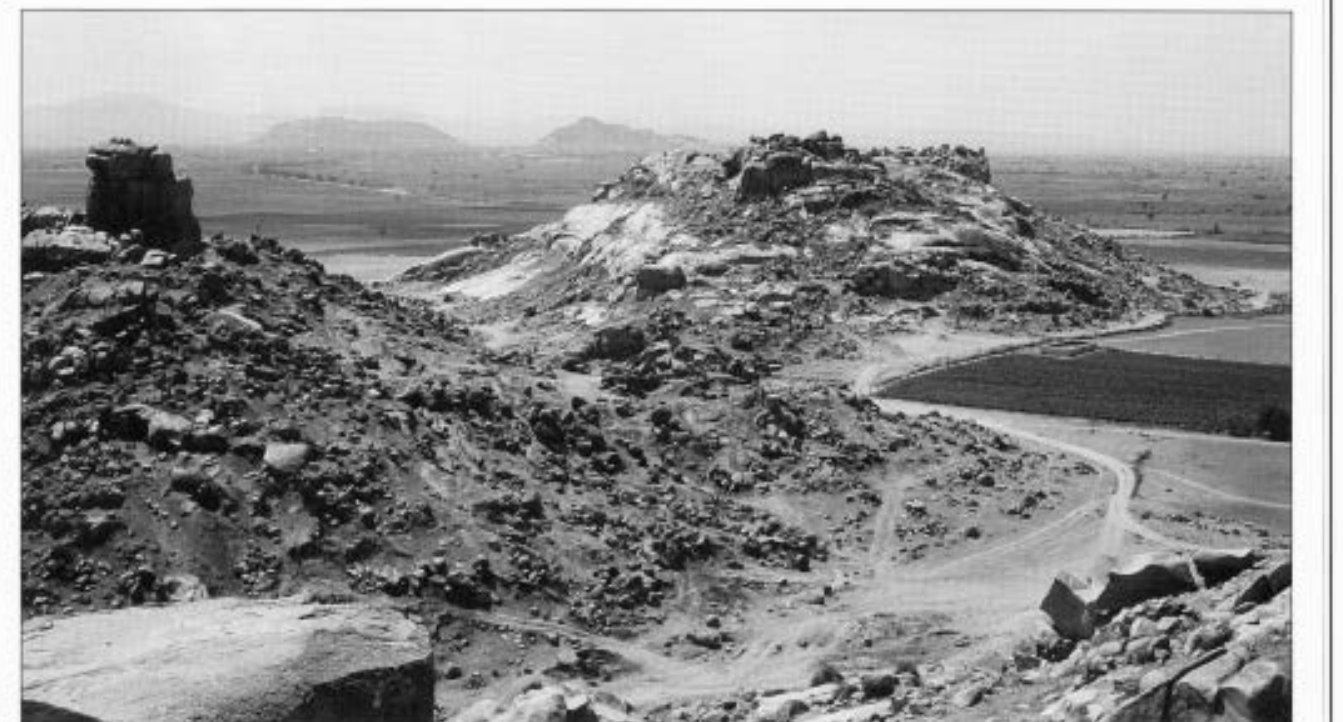
Figure 3 View southwest across a landscape of granitic hills and intervening plains in eastern Karnataka as seen from the hilltop site of Hiregudda. The archaeological village site of Sanganakallu is visible on the central